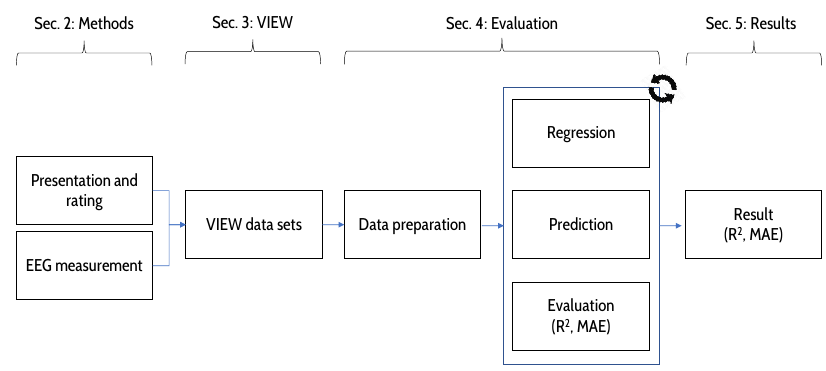
Figure 1. Overview of the methodology for creating and evaluating the Visual Interface Evaluation for Wearables (VIEW) datasets, including relevant sections in this paper; R 2 : Coefficient of determination; MAE: Mean Absolute